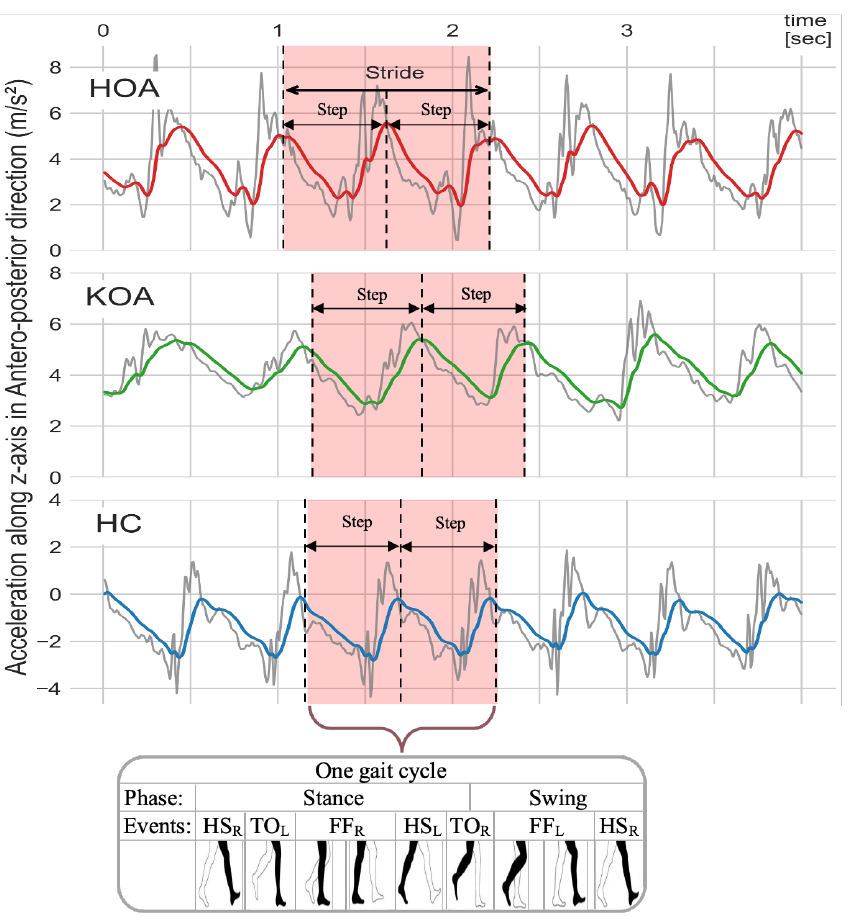
Figure 9. Raw ( gray colo r) and filtered AccAP ( red , green , and blue ) signals for HOA, KOA, and HC, respectively. The signals for HOA ( red ) and KOA ( green ) participants represent subjects who are experiencing pain, while the signal for the HC ( blue ) represents a subject without